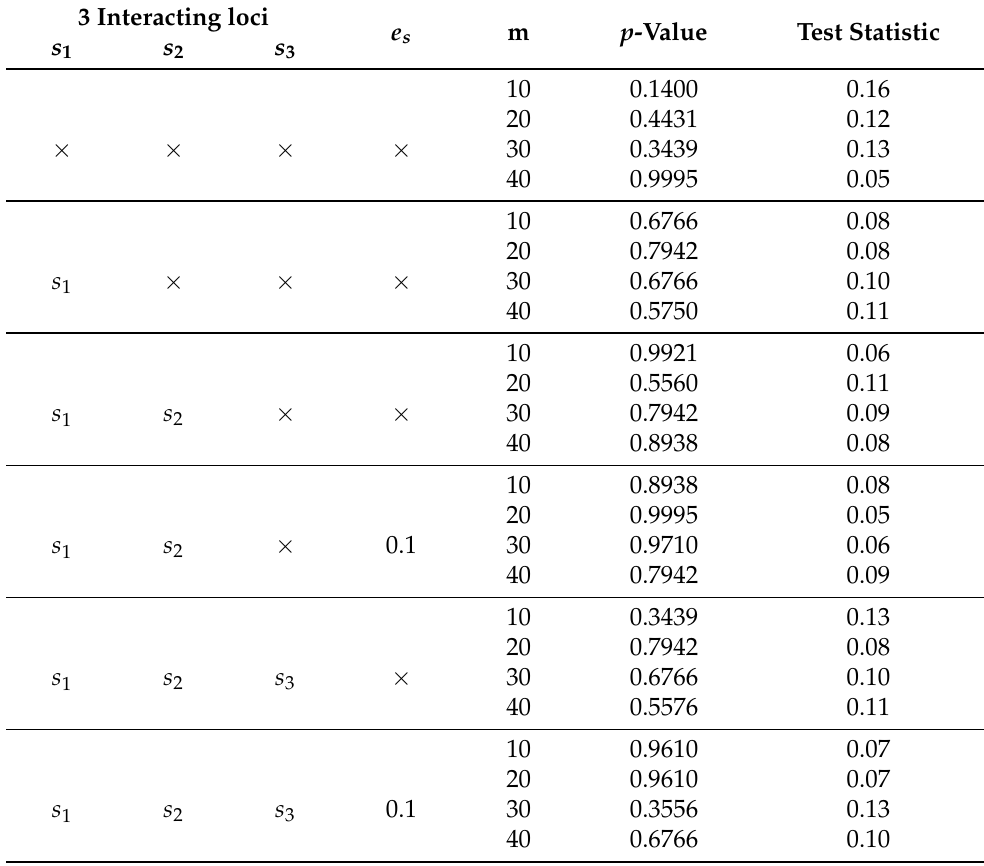
Table A1. K-S test statistics with corresponding p-values showing that the probability distributions of H as returned by fwd-sSimRA and back-sSimRA abstracts each other very